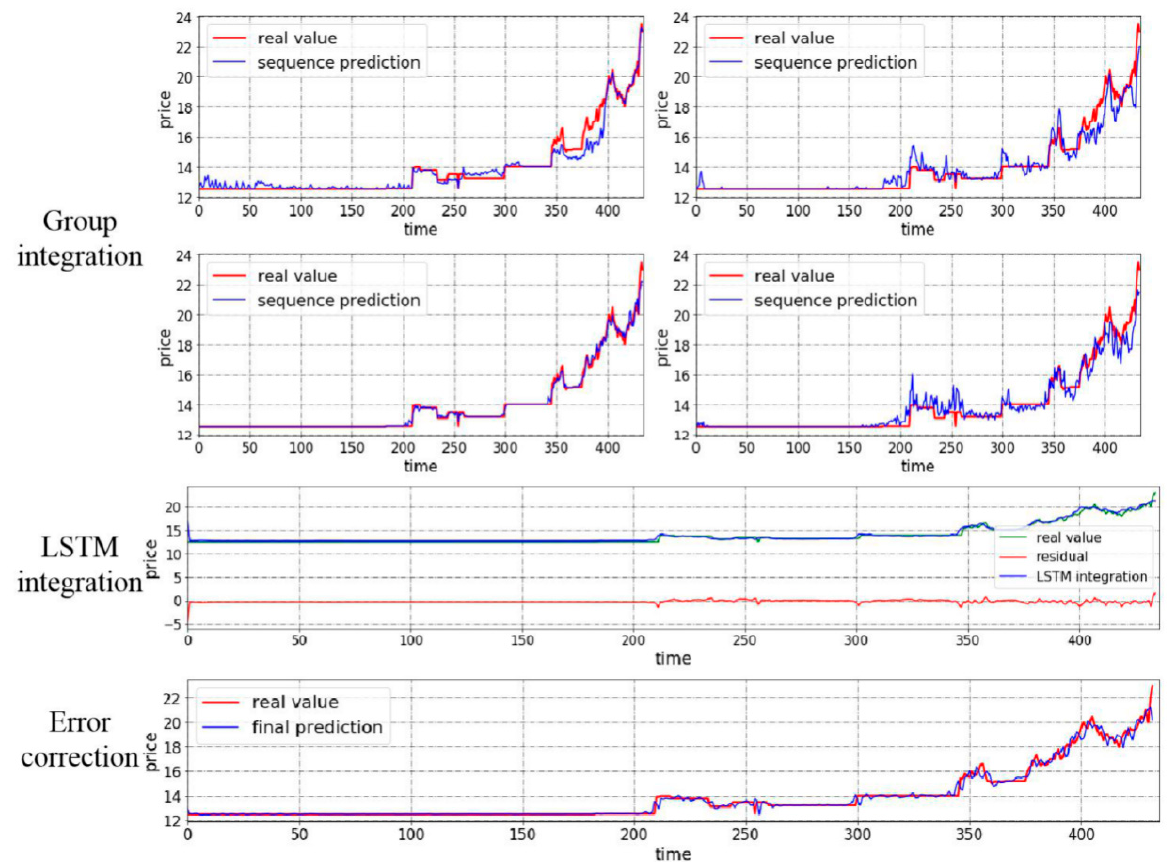
Figure 5. The point prediction of case 1.